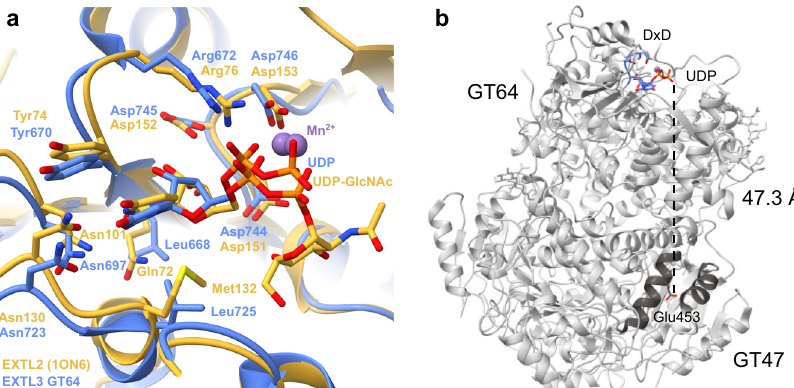
Fig. 6 UDP binding sites in EXTL3. Puri fi ed EXTL3 Δ N was incubated with UDP and subjected to cryo-EM single particle analysis in order to determine its structure. No density for UDP was visible in the GT47 domain. a Residues involved in binding UDP and Mn 2 + in mouse EXTL2 and the GT64 domain of human EXTL3. Human EXTL3 (in complex with UDP and Mn 2 + ) is shown in blue (phosphates in orange). Mouse EXTL2 (in complex with UDP-GlcNAc and Mn 2 + ; PDB: 1ON6) is shown in tan. b The GT64 active site and the apparently inactivated GT47 nucleotide binding site are separated by a substantial distance. The DxD motif and bound UDP of the GT64 domain are shown in blue. The C α 3 and C α 4 helices of the GT47 domain are shown in dark grey. The side chain of Glu453 is shown in